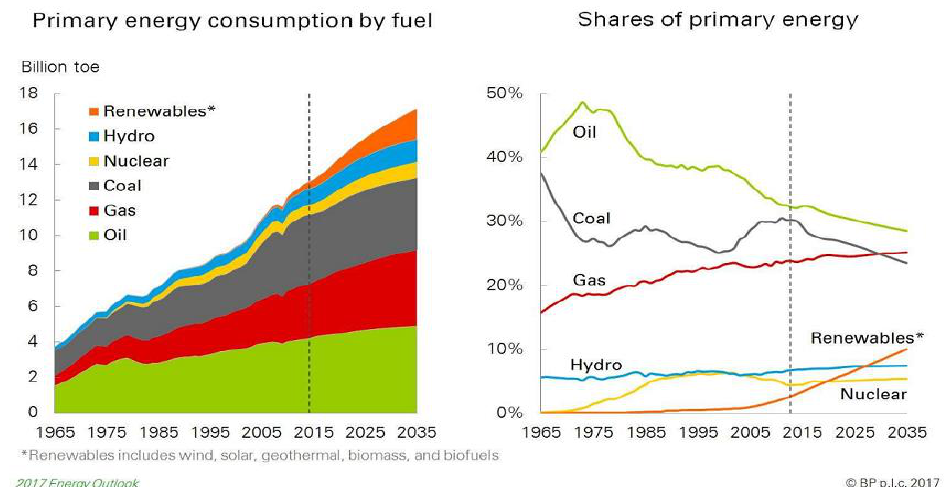
Figure 1. Trends in worldwide energy consumption from 1965 to 2035. Source: https://www.ogj.com/ articles/2017/01/bp-energy-outlook-global-energy-demand-to-grow-30-to-2035.html.